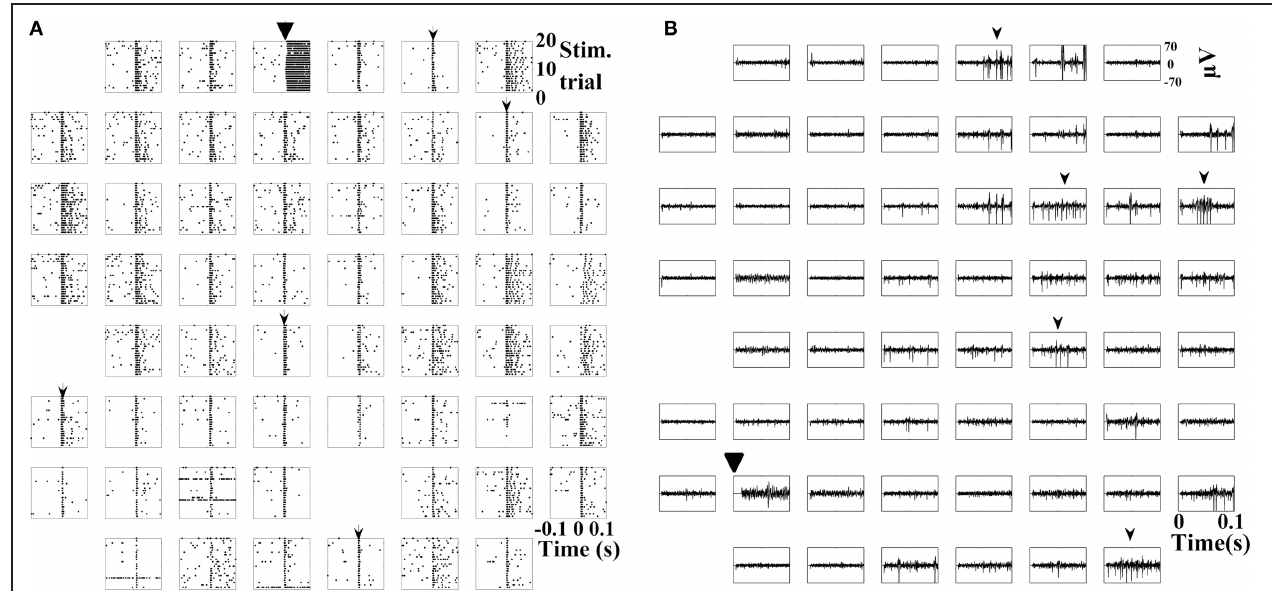
post-stimulation of SALPA filtered traces on all 59 electrodes of a MEA. Synaptic activity evoked on multiple electrodes (small black arrowheads). Representative examples ( A , cortical culture age six weeks; B , hippocampal culture age seven weeks) from n = 152 electrodes in six cultures (two cortical and four hippocampal). TTX was not present in the